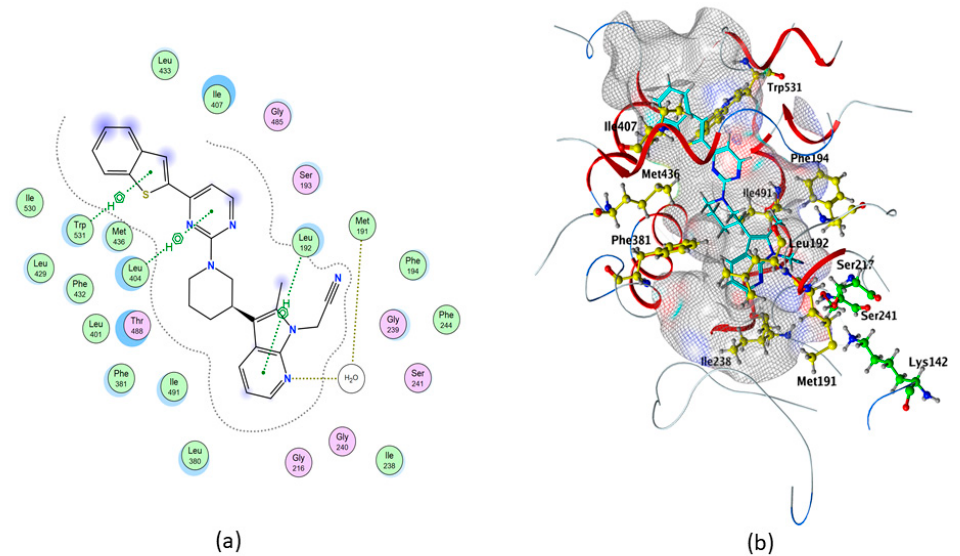
Figure 2. Best binding pose of QK5 within rFAAH, obtained through MOE analysis. ( a ) In the 2D structure the following details are shown: Pi–H interactions, in green; backbone acceptor, in blue; solvent contact, in yellow. ( b ) In the 3D structure the following elements are shown as sticks: QK5, in cyan; catalytic triad, in green; all residues involved in the protein/ligand interaction, in yellow.